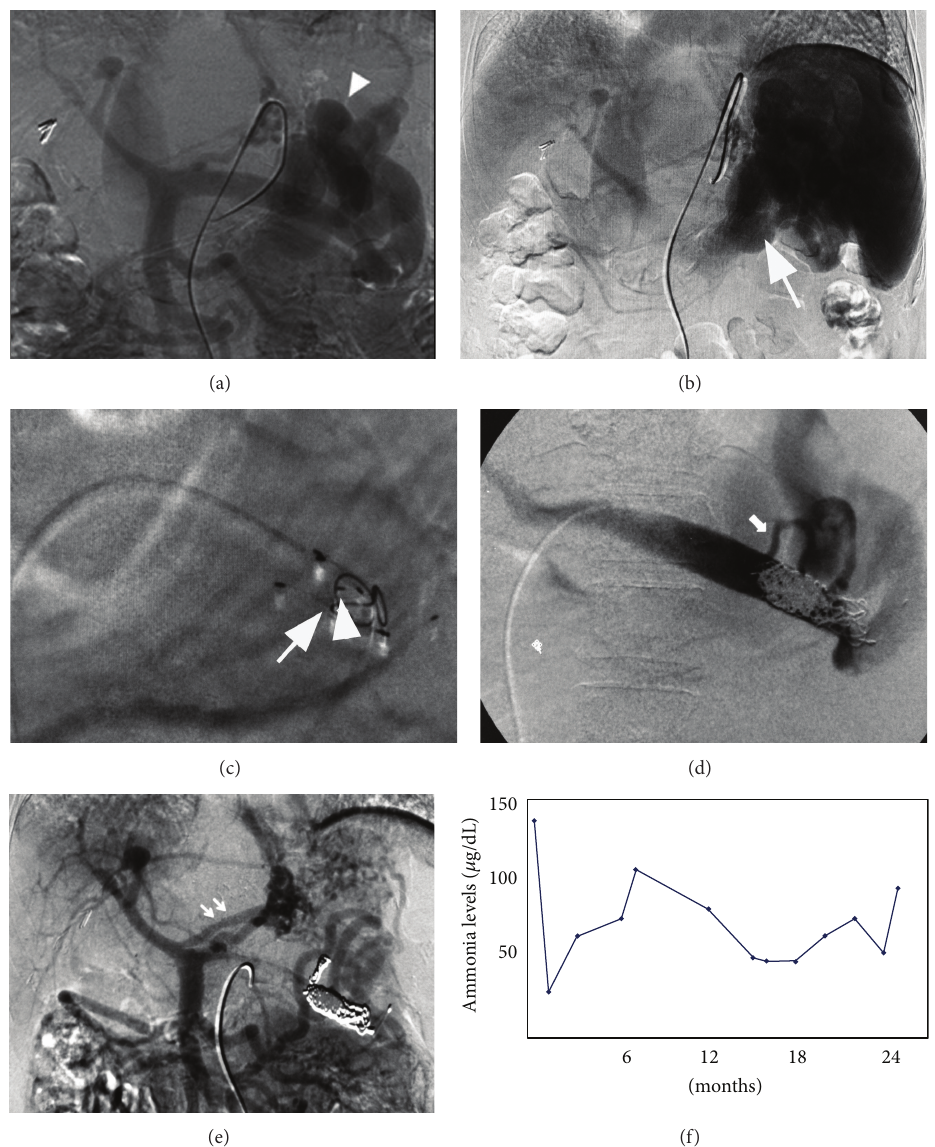
Figure 1: (a) Portography from the superior mesenteric artery shows the hepatofugal flow in the splenic vein and a large splenorenal shunt (arrowhead). (b) The venous phase of a selective splenic arteriogram shows that the splenic venous blood flows into the left renal vein via the splenorenal shunt (arrow). (c) A device (Coil Anchor, Medikit Co., Miyazaki, Japan) (arrowhead) to prevent migration of the coils has been placed. After the placement of this device, one 0.035-inch platinum coil was placed (arrow). (d) Selective splenovenography after embolization of the splenic vein shows the development of a hepatofugal collateral, retrogastric vein (arrow), connected to the splenorenal shunt. This collateral was embolized with 2 microcoils. (e) Portography from the superior mesenteric artery after embolization demonstrates a clear depiction of portal branches and no splenorenal shunt. There was hepatofugal flow via the coronary vein (double arrow), but it was not embolized to avoid increasing portal pressure. (f) Venous blood ammonia levels measured after the procedure. The patient had encountered no symptoms of hepatic coma for 24 months after